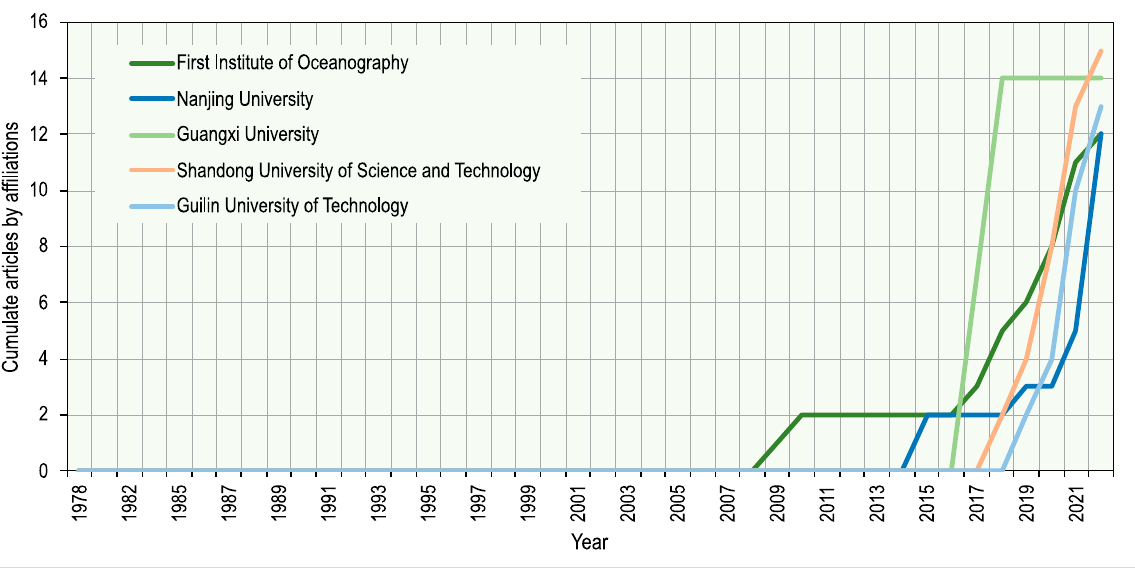
Figure 9. Cumulative number of articles dealing with optical SDB for five affiliations within time interval 1978-2021.